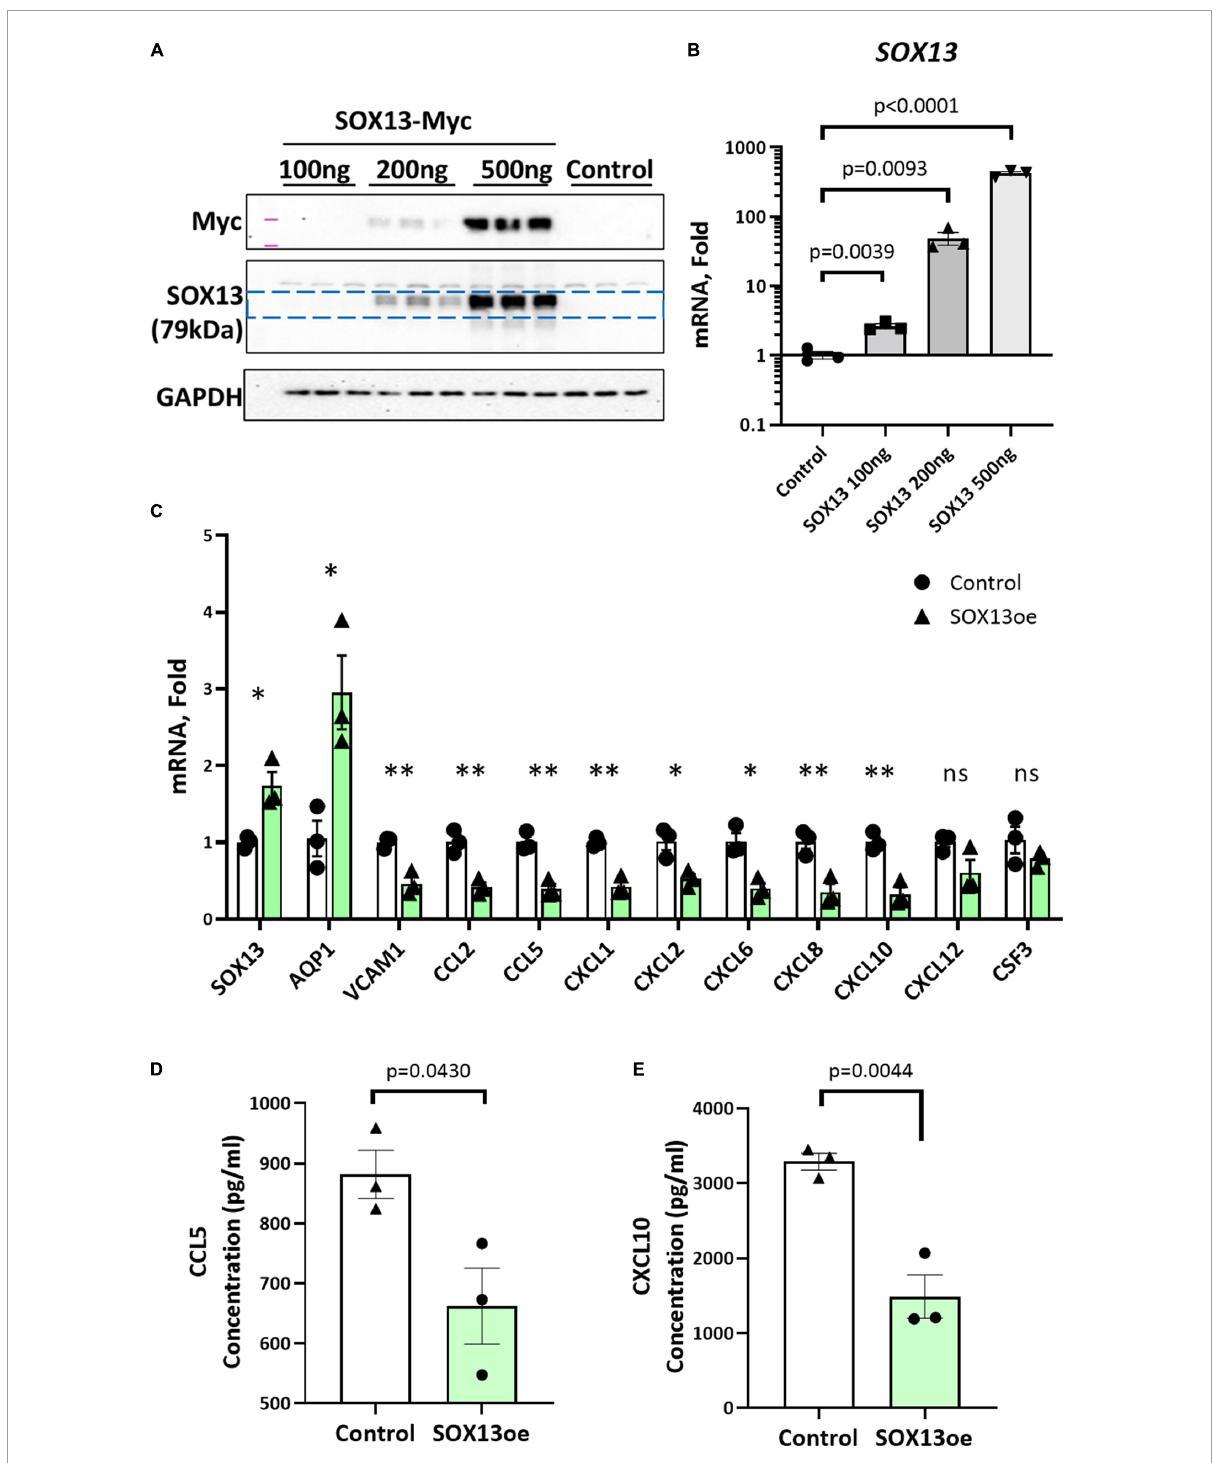
FIGURE7 SOX13 plasmid overexpression reduces inflammatory markers and chemokine expression. (A) Western blot of whole cell lysate and (B) qPCR of SOX13 plasmid concentration curve in static HAECs after 48h compared to GFP control plasmid. (C) qPCR analysis of SOX13 targets following 48 h static SOX13 or GFP control overexpression in HAECs at a concentration of 200 ng, using SOX13 and AQP1 as positive controls. n = 3, Mean ± SEM are shown. * p ≤ 0.05, ** p ≤ 0.01 as determined by student’s t -test. (D) ELISA quantification of CCL5 and (E) CXCL10 in the conditioned media from static HAECs, 48 h following SOX13 or control plasmid transfection. Mean ± SEM are shown, n = 3, p -values determined by student’s t